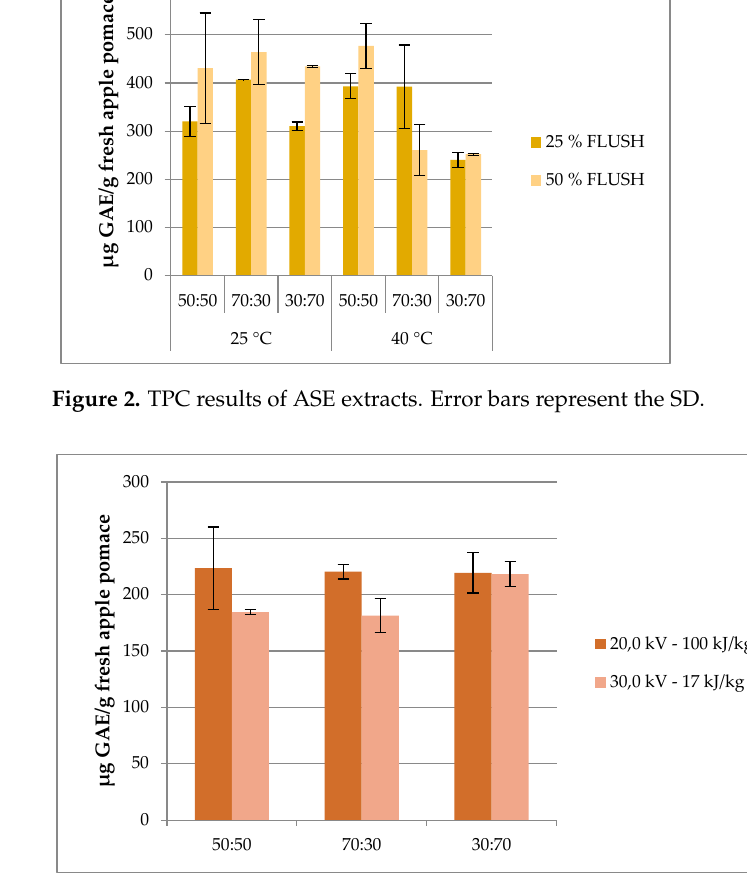
Figure 2. TPC results of ASE extracts. Error bars represent the SD.